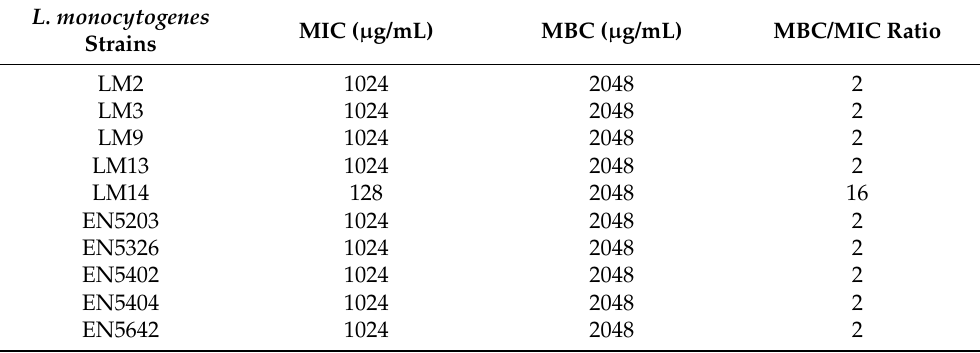
Table 2. Minimum inhibitory concentration (MIC) and minimum bactericidal concentration (MBC) of COS-EGCG conjugate against environmental and clinical strains of L. monocytogenes